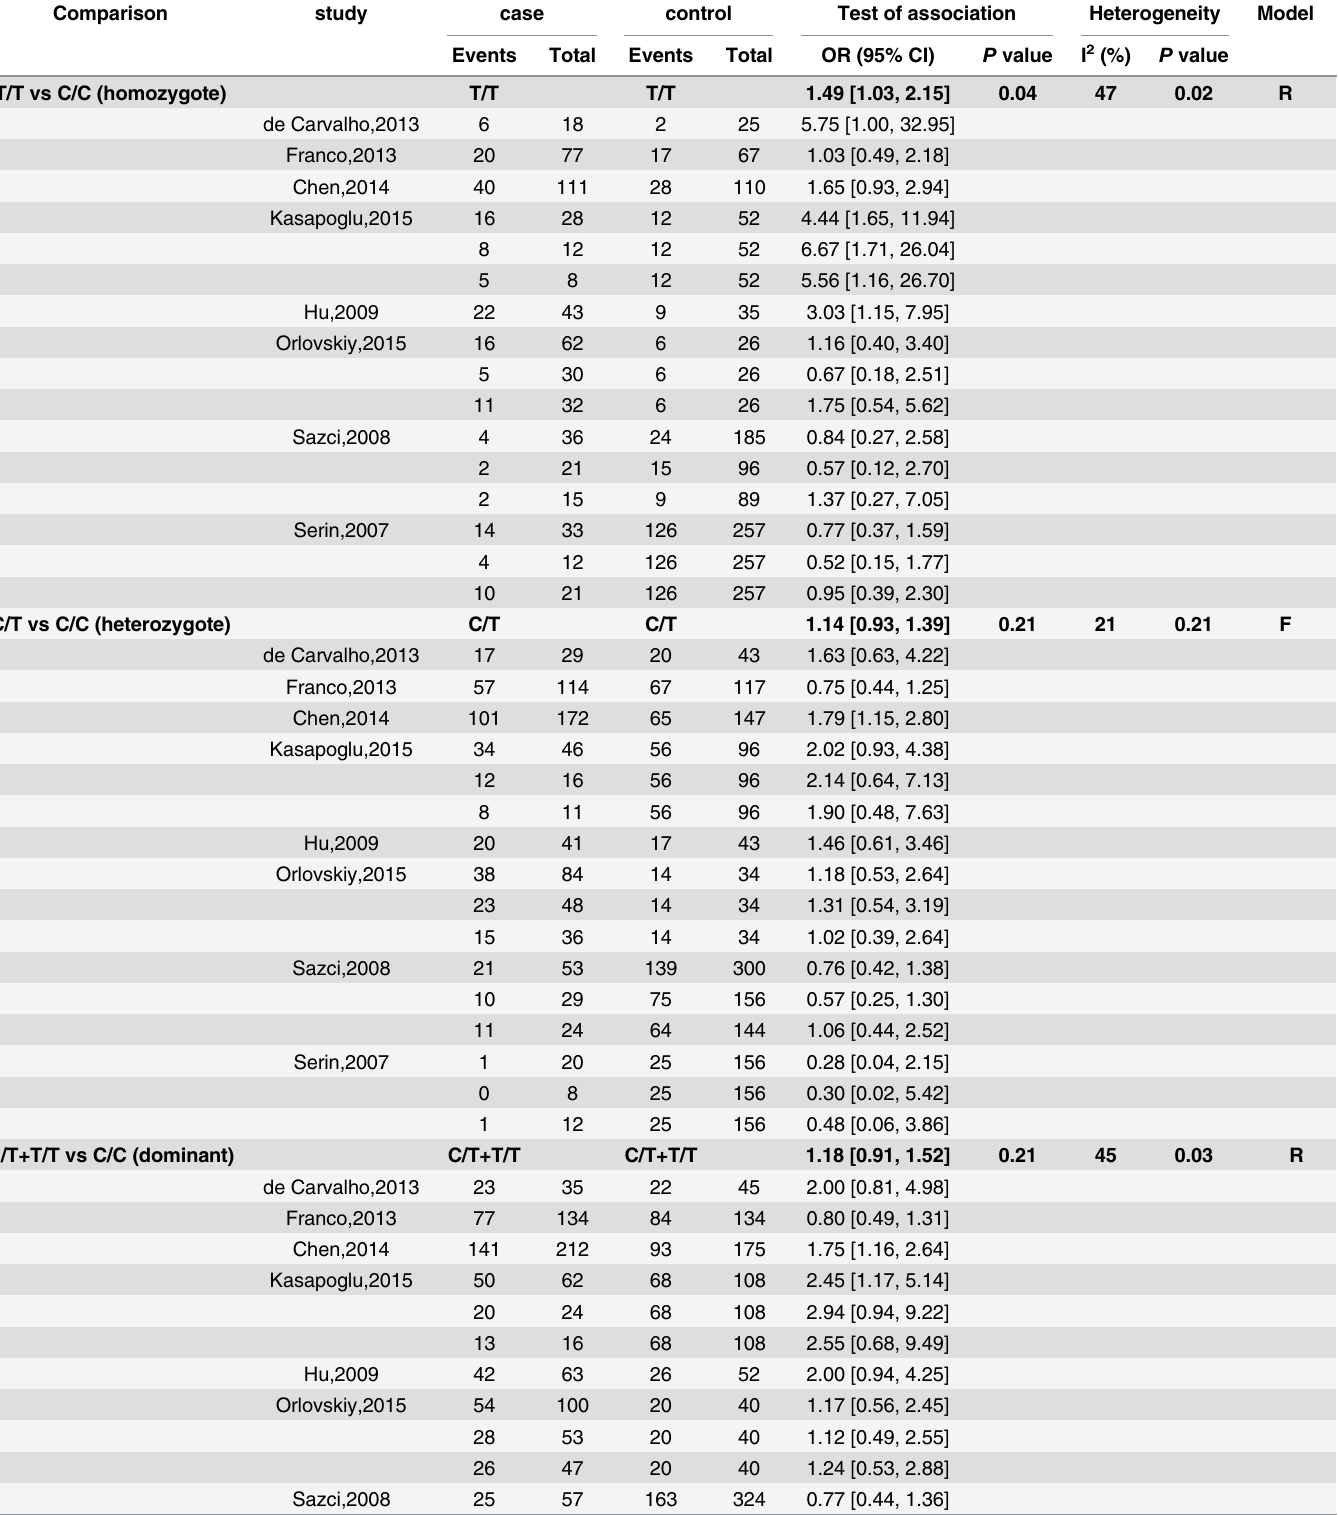
Table 3. Pooled analysis for the association between MTHFR C677T genotype frequencies and the risks of NAFLD. Comparison